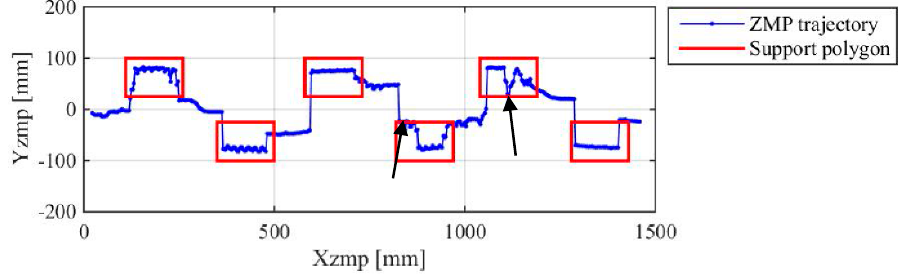
Figure 16. ZMP trajectory of the biped robot in the case of walking with the rigid flat feet. Appl. Sci. 2017 , 7 , 1005